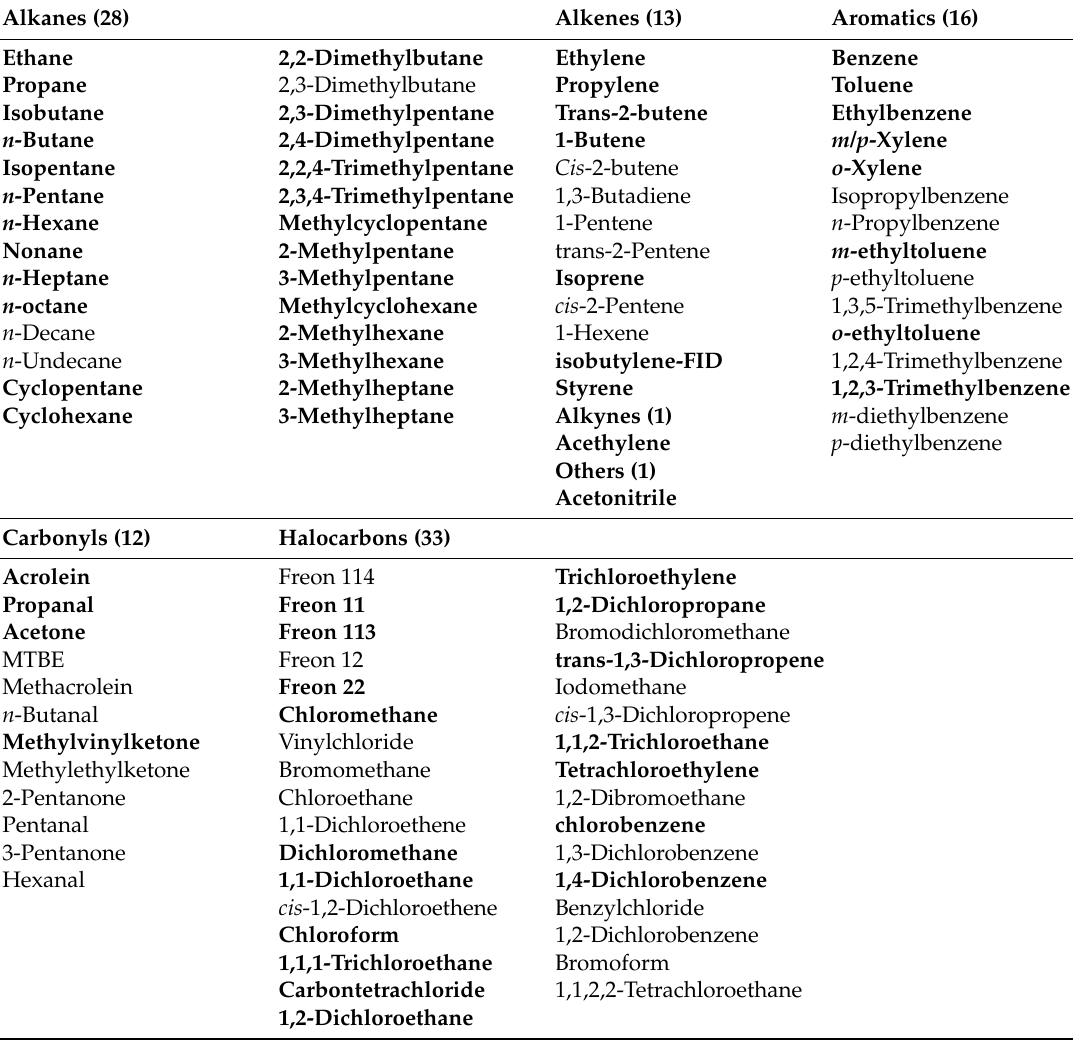
Table 2. VOC species analyzed by the gas chromatography–mass spectroscopy (GC–MS) system (species considered for positive matrix factorization (PMF) analysis are in